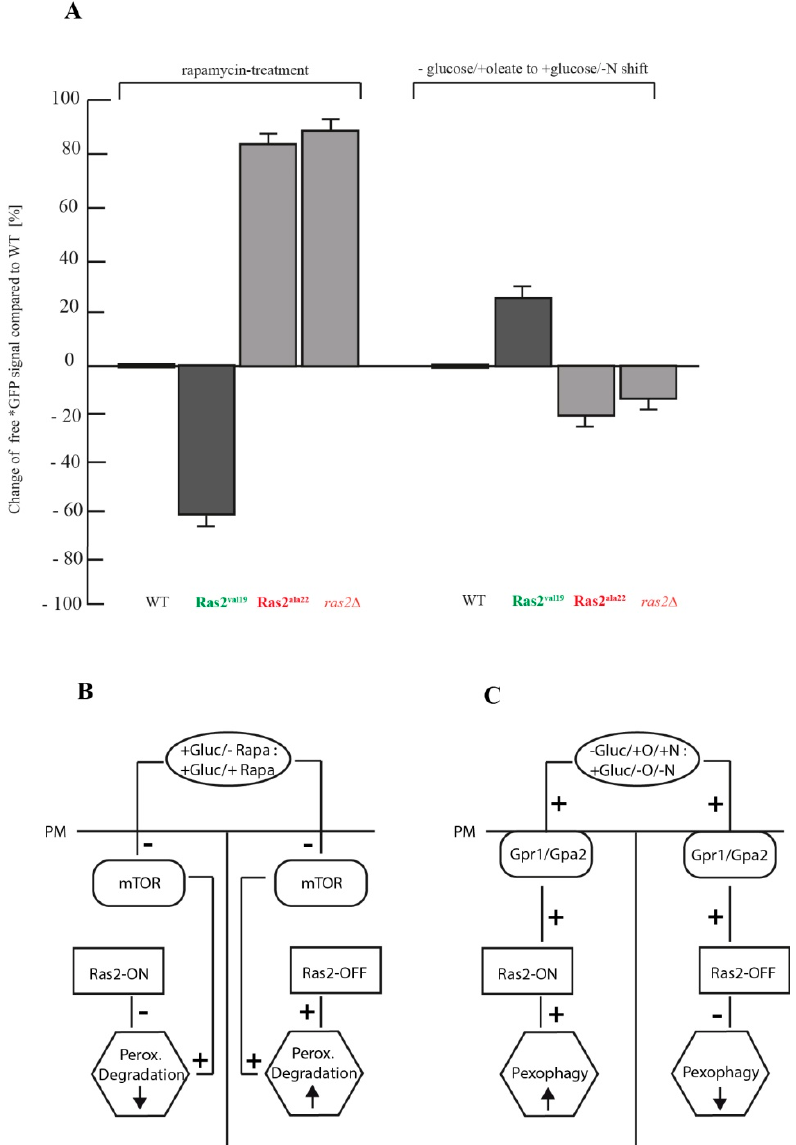
Figure 4. Comparison of the autophagy stimulus-dependent effects of the Ras2 activity mutants on peroxisome degradation. ( A ) The change of the relative amount of generated free *GFP compared to the wild-type (WT) was calculate on basis of the densitometric data of the *GFP signals after 23 h ( n = 5) after rapamycin-treatment and after the shift from glucose-lacking oleate medium to glucose-containing pexophagy medium. ( B ) Working model part I: Ras2 and mTOR inhibit peroxisome-degradation in glucose-grown cells. After inactivation of mTOR via rapamycin, only the constitutively active Ras2 ON (Ras2 val19 ) can partially downregulate peroxisome degradation. In case that not only mTOR is inhibited by rapamycin but also the inactivated species Ras2 OFF (Ras2 ala22 ) is expressed, peroxisome degradation can occur in an enhanced manner. PM = plasma membrane. ( C ) Working model part II: Ras2 is required for efficient pexophagy. Peroxisomes are essential for the cell when grown in oleate as sole carbon source. The shift to glucose-containing medium induced the degradation of an excess of peroxisomes, as they are not essential anymore. This effect is enhanced by the inhibition of mTOR via reduced nitrogen-sources in the medium. Ras2 is known to mediate glucose-sensing induced signaling, involving Gpr1 and Gpa2. Here, Ras2 ON supports a rapid sensing of the glucose signal and contributes to enhance pexophagy. In contrast, the Ras2 OFF delays the sensing of the presence of the added glucose and therefore decreases pexophagy efficiency.